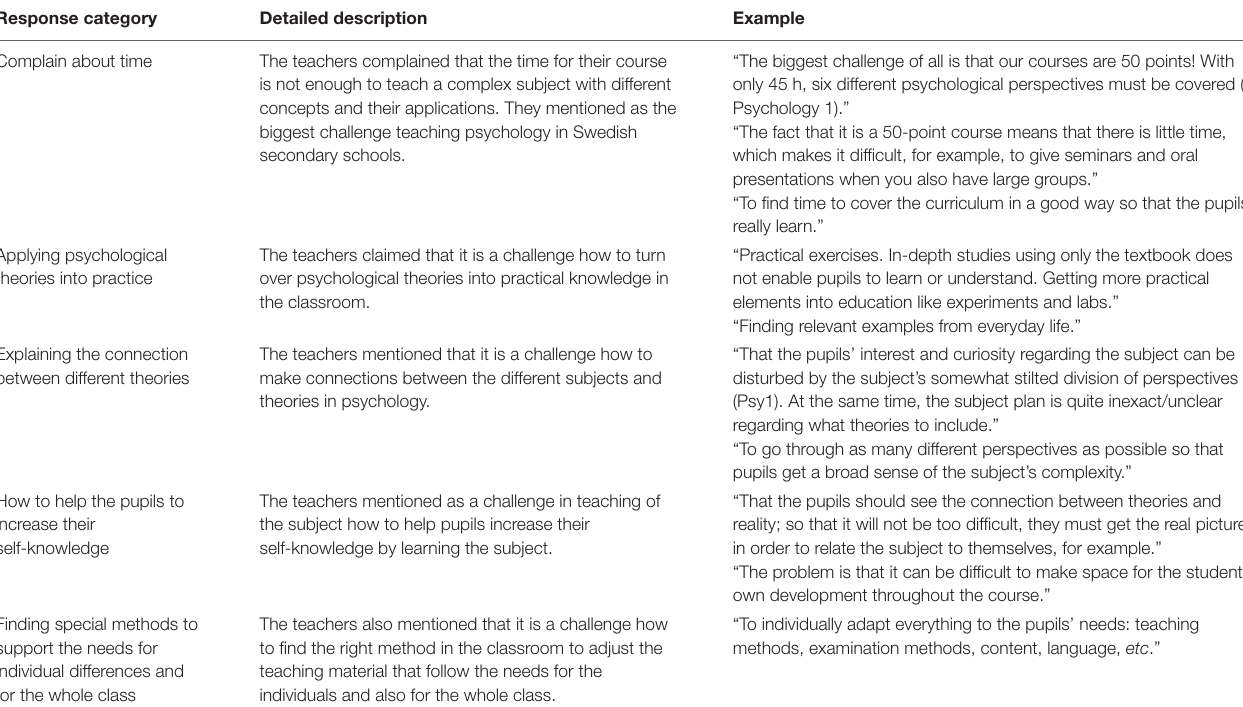
TABLE 4 | What is the biggest challenge for psychology teachers when the subject plan is to be transformed into didactic work in the classroom?